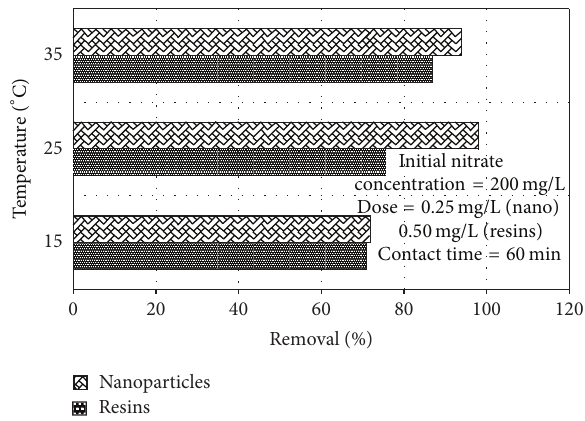
Figure 5: Effect of temperature on nitrate removal by resins and Fe/Pt bimetallic nanoparticles.